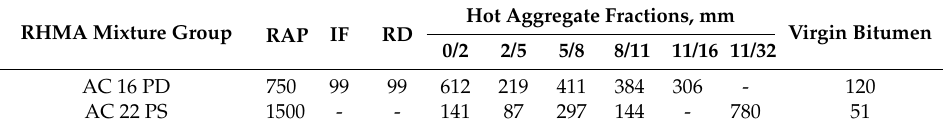
Figure 8. Normal distribution curves and statistical indices of histogram of RAP percentage content in recycled hot mix asphalt (RHMA) mixture, when its content according to JMF had to be: ( a )—25%; ( b )—50%.